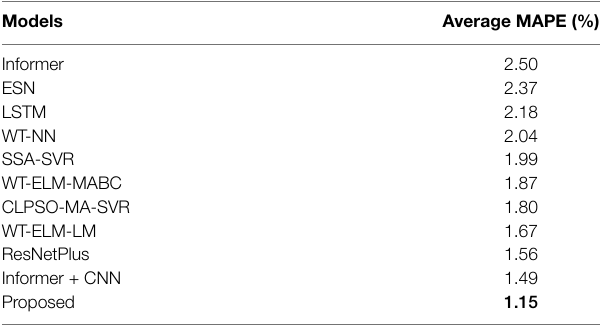
TABLE 2 | Forecast results for the testing set of the North-American Utility data